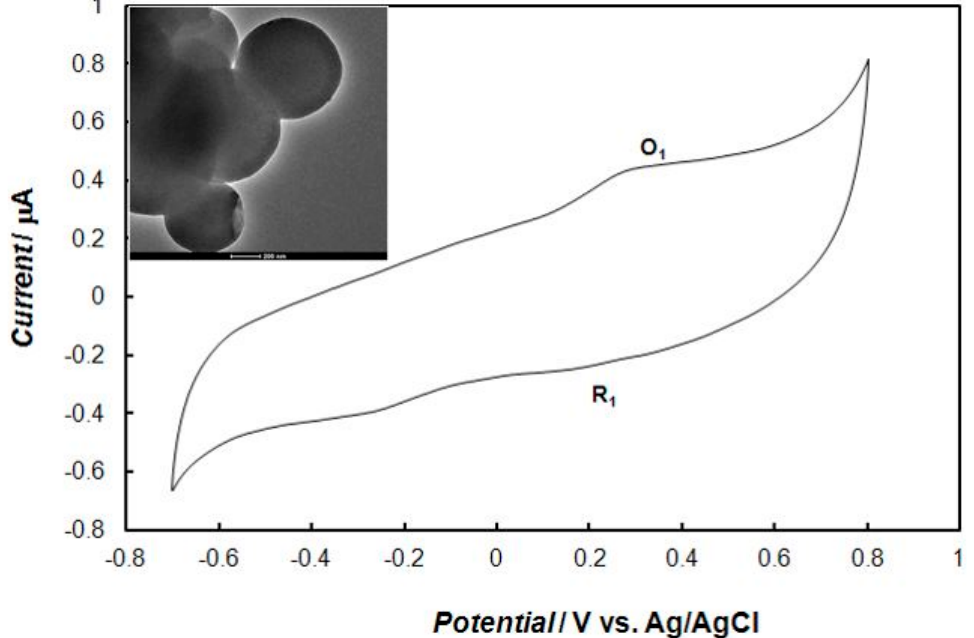
Cyclic voltammogram that was recorded at the gold electrode modified with the polypyrrole—MCM-48 nanocomposite in 0.1 M of phosphate buffer solution (pH = 7.4). The potential sweep rate was 0.1 V s − 1 . The inset in figure shows TEM image of the polypyrrole—MCM-48.